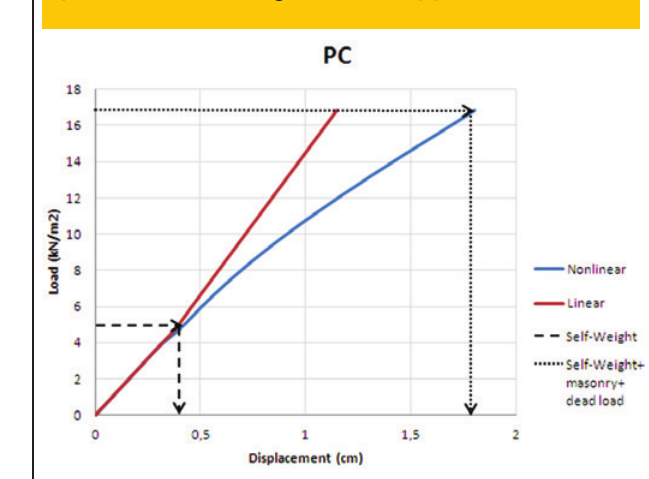
Figure 9 – Vertical displacements of instrumentation point PC concerning the loads applied on